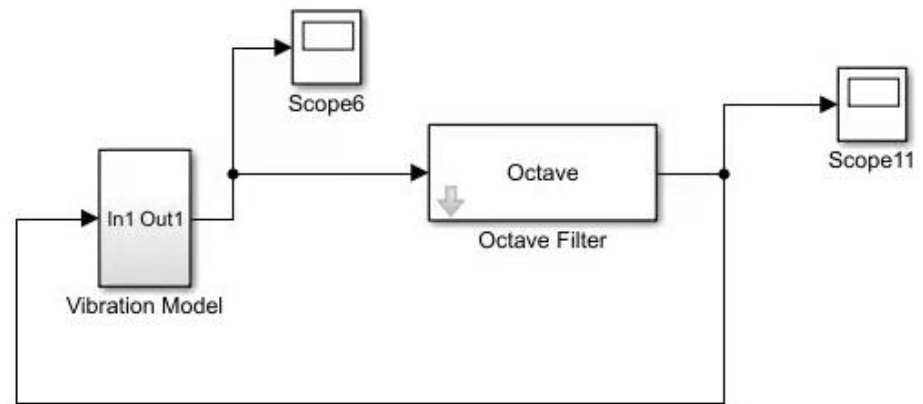
Figure 11. The dynamics Simulink model using the OCTAVE vibration control.